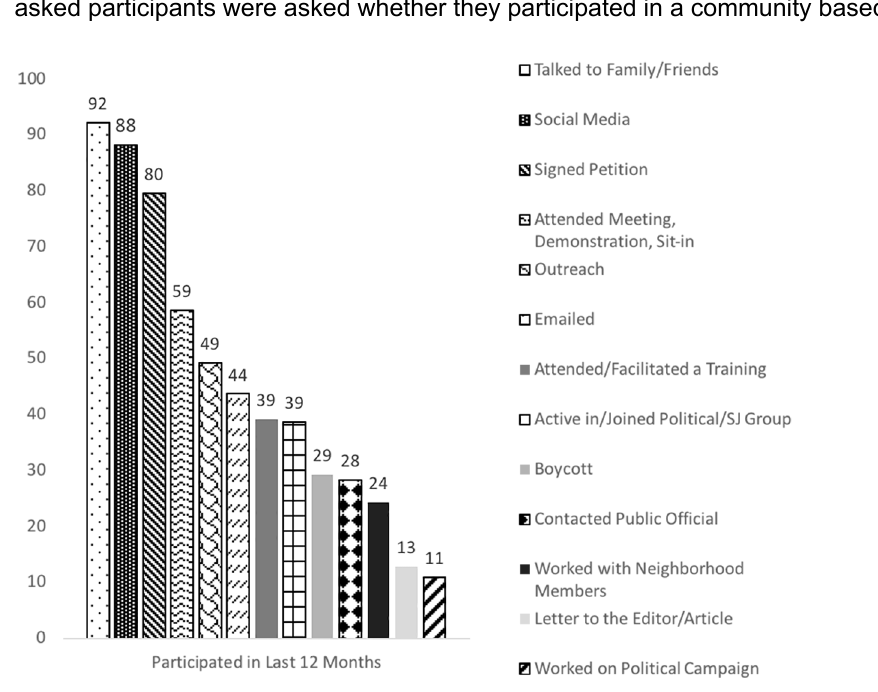
Figure 2. Percent of youth involved in activist